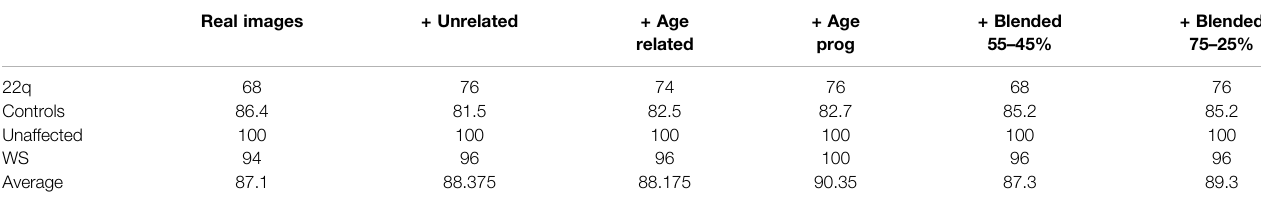
TABLE 2 | Accuracy of the classi fi er trained on real images compared to classi fi ers trained on both real images and each of the four types of fake images. Column names unrelated, age related, age progression (age prog), and blended correspond to fake GAN images of type 1, 2, 3, and 4, respectively. The greatest improvement in accuracy was observed with the addition of age progression fake